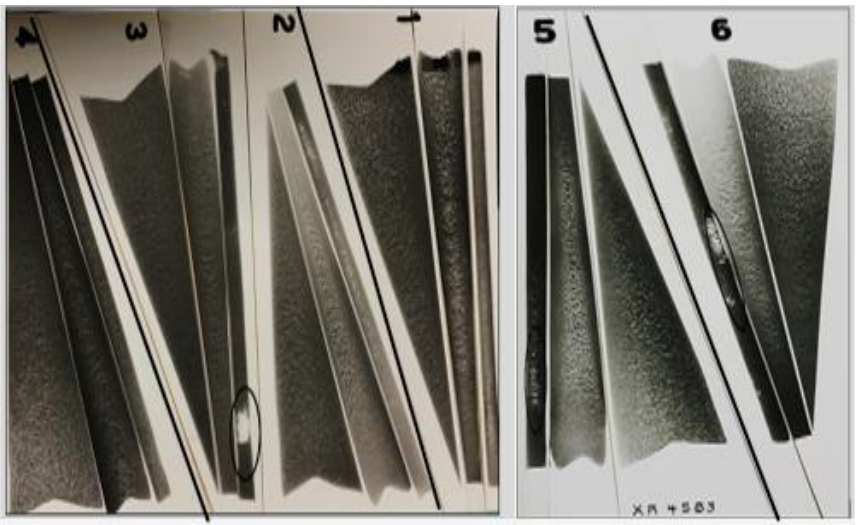
Figure 2. X-ray radiographs taken from several castings at the three opening angles shown in Figure 1e. The numbers 1 to 6 simply represent a batch of castings taken from a specific melt in each case.